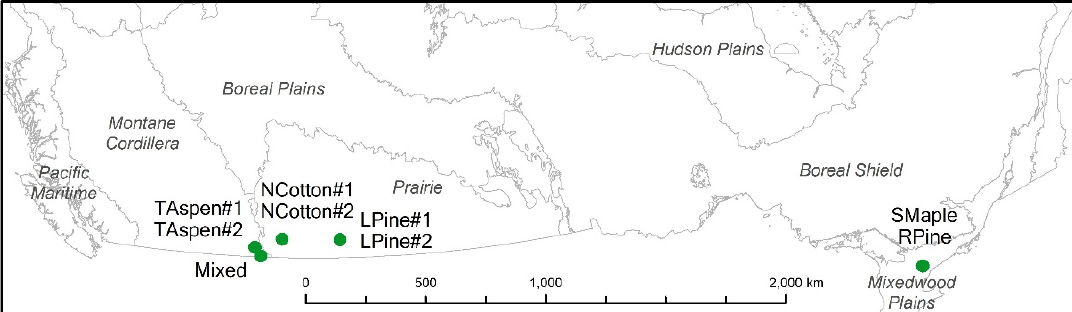
Figure 1. Geolocations of nine Canadian sites with TLS scan collection. Ecozone names are italic. Green dots indicate plot locations and nearby labels show plot ID names. Table 1. Characteristics of sixteen TLS plots.